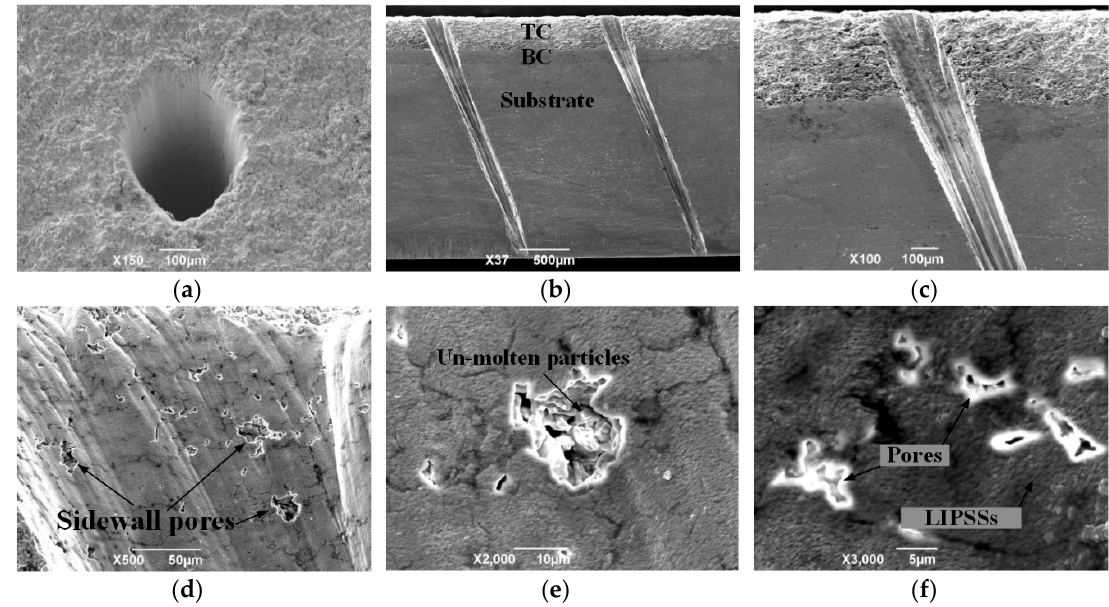
Figure 1. ( a ) Low-magnification image of the sample surface; ( b , c ) cross-sectional morphology; ( d )–( f ) walls of holes drilled with a femtosecond (fs) laser at 5 W power and 1 kHz repetition rate through a Ni superalloy with thermal barrier coating (TBC). LIPSSs: laser-induced periodic surface structures.